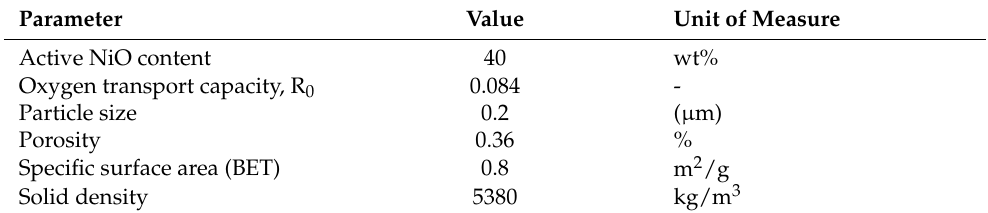
Table 3. Ni40Al-FG Oxygen carrier characteristics [17].